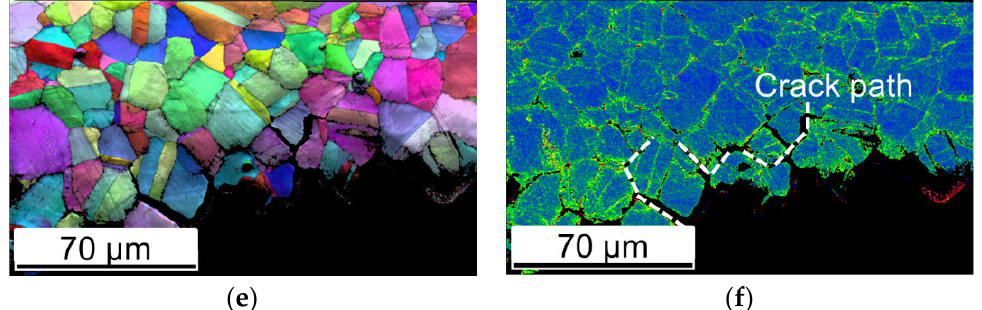
Figure 7. IPF maps of ruptured samples ( a ) DA, ( c ) HIP-DA, ( e ) Wrought; KAM maps ( b ) DA, ( d ) HIP-DA, and ( f ) Wrought, respectively.